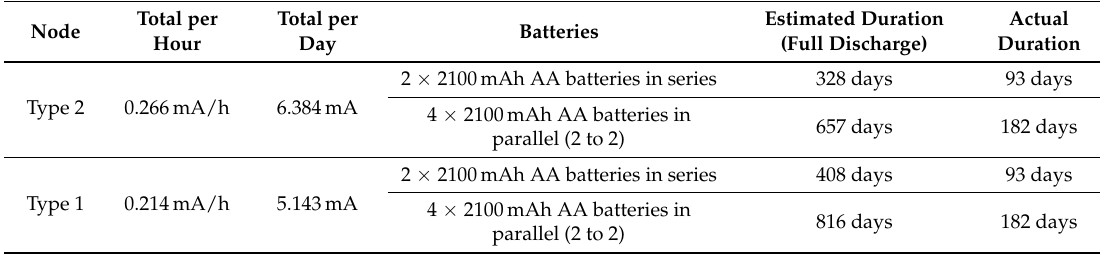
Table 5. Total consumption and duration for each type of